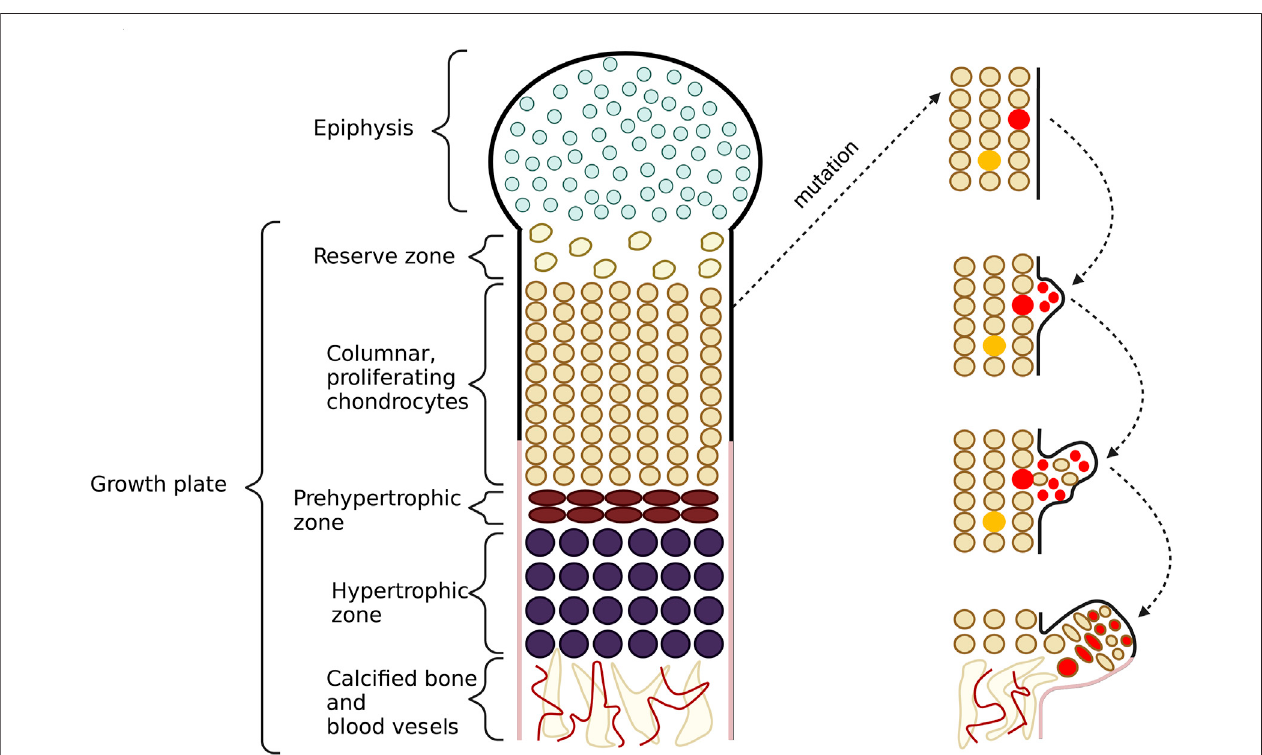
FIGURE5| This fi gureshowstheschematicformationofexostoses.Inthegrowthplate,onecanobserveaproliferationzoneofchondrocytesresponsibleforbone elongation.Duringthisprocess, cellsfromtheupperlayersproliferate,whilecellsfromthelowerlayersundergoapoptosisandthencalcify.Asaresultofmutationsinthe EXT1 and EXT2 genes, chondrocytes with shortened heparan sulfate (HS) chains appear in this area. If the cell is located in the middle column, it can be rescued by the neighboringcellswhithnormallengthHSchains.Inthiscase,exostosesdonotform.Conversely,ifthecellispresentintheoutercolumns,itescapesfromanormal differentiation process. The cell loses its polarity but still keeps its proliferation potential. Then, the cell starts to translocate to lower layers of chondrocytes and grabs some non-mutated cells with it too. In the last stage, the cells form exostoses.